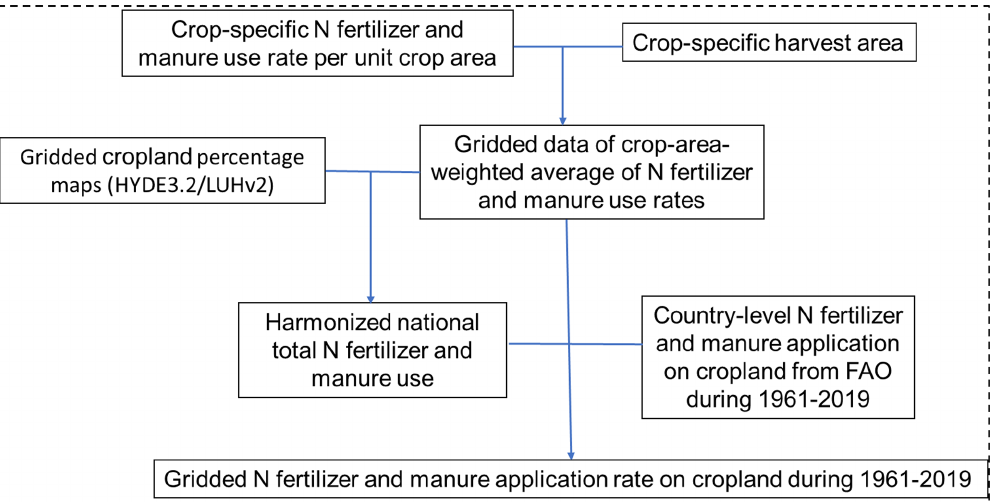
Figure 1. The workflow for developing the dataset of global annual N fertilizer and manure application rates for the period from 1961 to 2019.